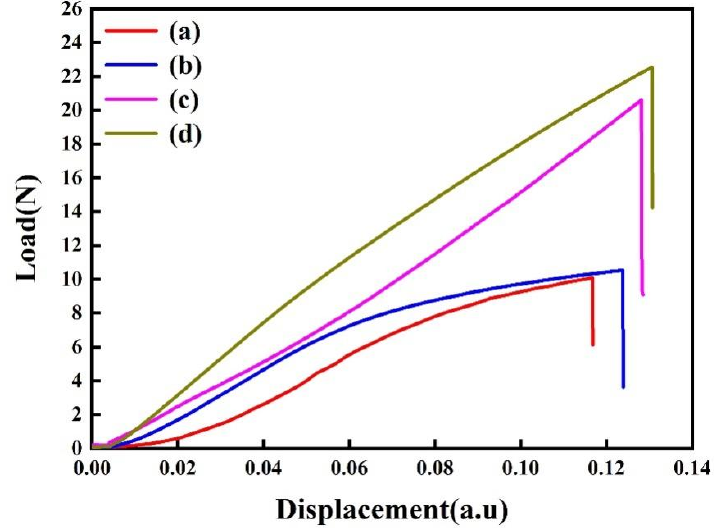
Figure 5. Interfacial toughness of samples: ( a ) As-deposited Cu/APTMS/SiO 2 /Si; ( b ) As-deposited Cu/COOH-APTMS/SiO 2 /Si; ( c ) Cu/APTMS/SiO 2 /Si annealed at 400 °C; ( d ) Cu/COOH- APTMS/SiO 2 /Si annealed at 400 °C. Table 1. Interface toughness of samples.